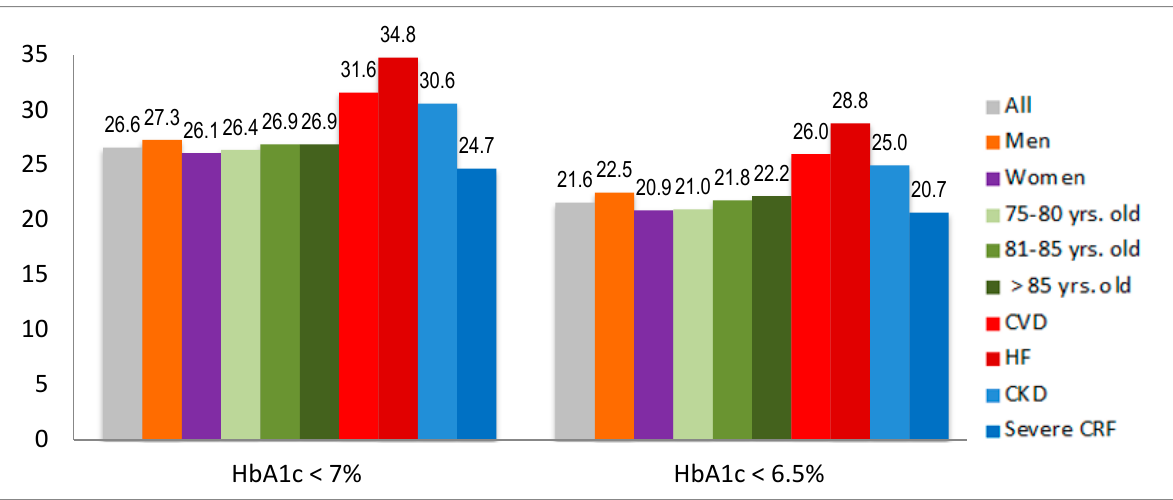
Figure 3. Potential overtreatment according to an HbA1c < 7.0% or an HbA1c < 6.5% criteria by sex and age subgroups and comorbidities. CVD: cardiovascular disease; HF: heart failure; CKD: chronic kidney disease; CRF: chronic renal failure.